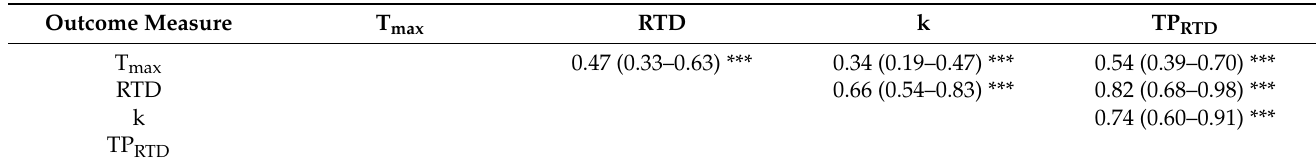
T max -maximal isometric torque; RTD-rate of torque development; k-slope of regression line (rate of force development scaling factor); TP RTD -theoretical peak of RTD. Table 3. ANOVA effect sizes and 95% CI for paired comparisons between symmetry values.